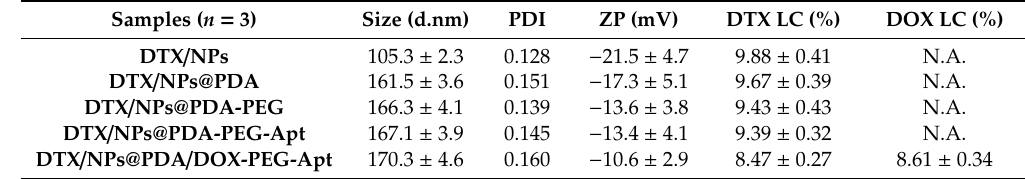
Table 1. Characterization of drug-loaded polymeric nanoparticles (NPs).